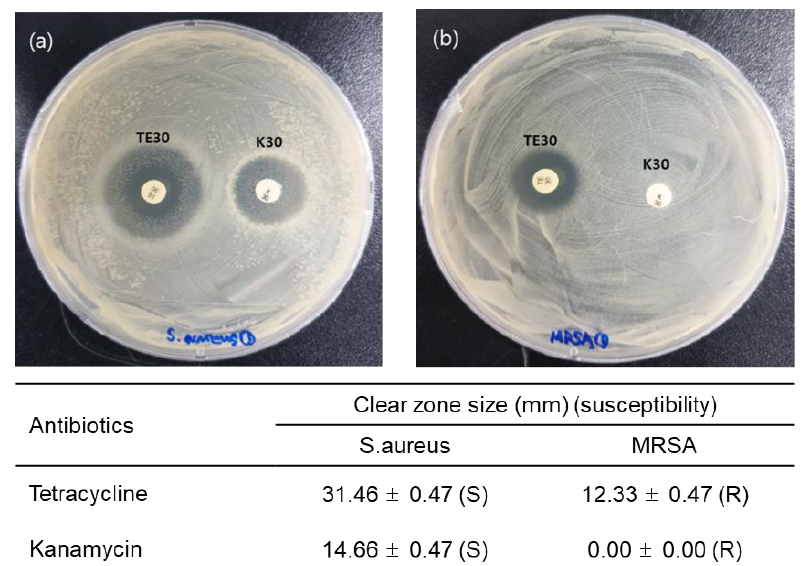
Figure 3. Antibiotic susceptibility test of ( a ) S. aureus or ( b ) MRSA was performed using discs containing the antibiotics, tetracycline 30 μg/mL (TE30), and kanamycin 30 μg/mL (K30), and by measuring the clear zone (S: susceptible, R: resistive).